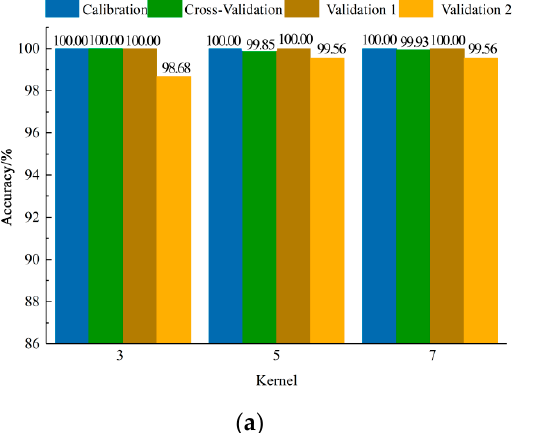
Figure 8. Results of CNN-ELM models with different convolution kernel sizes based on mean spectral information ( a ) per direction and of ( b ) four directions.